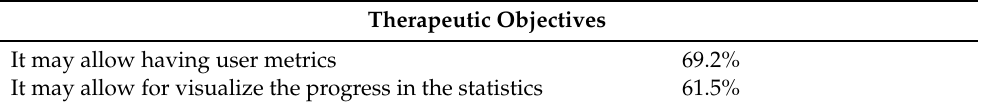
Table 7. Therapeutic objectives in which Kina contributes according to the experts’